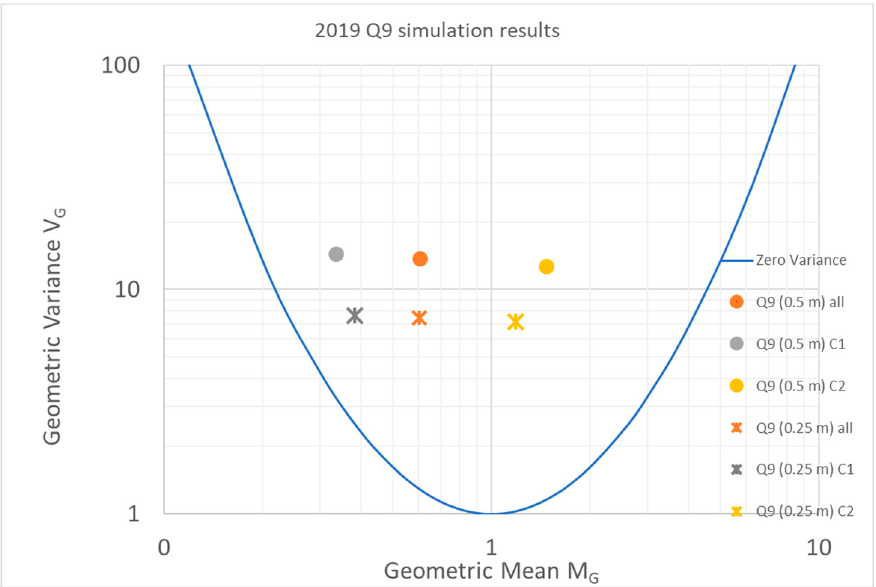
Figure 9. MV diagram showing the results using two grid sizes (0.5 m and 0.25 m) using current explosion risk assessment (ERA) methodology.